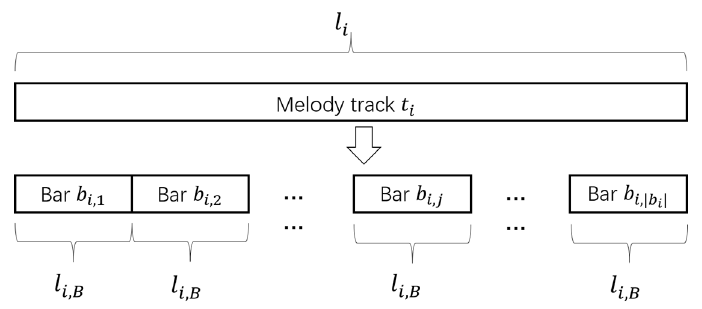
Figure 4. Bar segmentation.